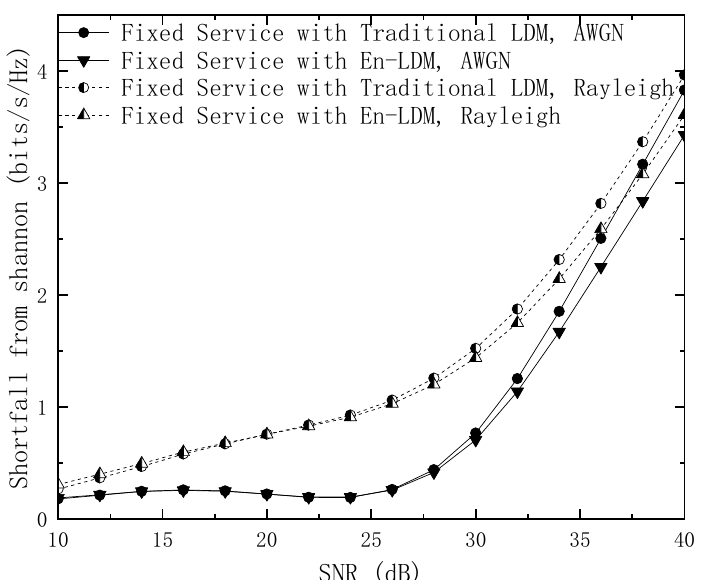
Figure 4. The shortfall from Shannon for the fixed service of the LDM and En-LDM systems under the AWGN and Rayleigh channels, where the parameters of the LDM and En-LDM systems were set to 10   dB, 1 4 f t B B  , the CL constellation was set to QPSK, and the EL constellation was set to NU−64QAM.